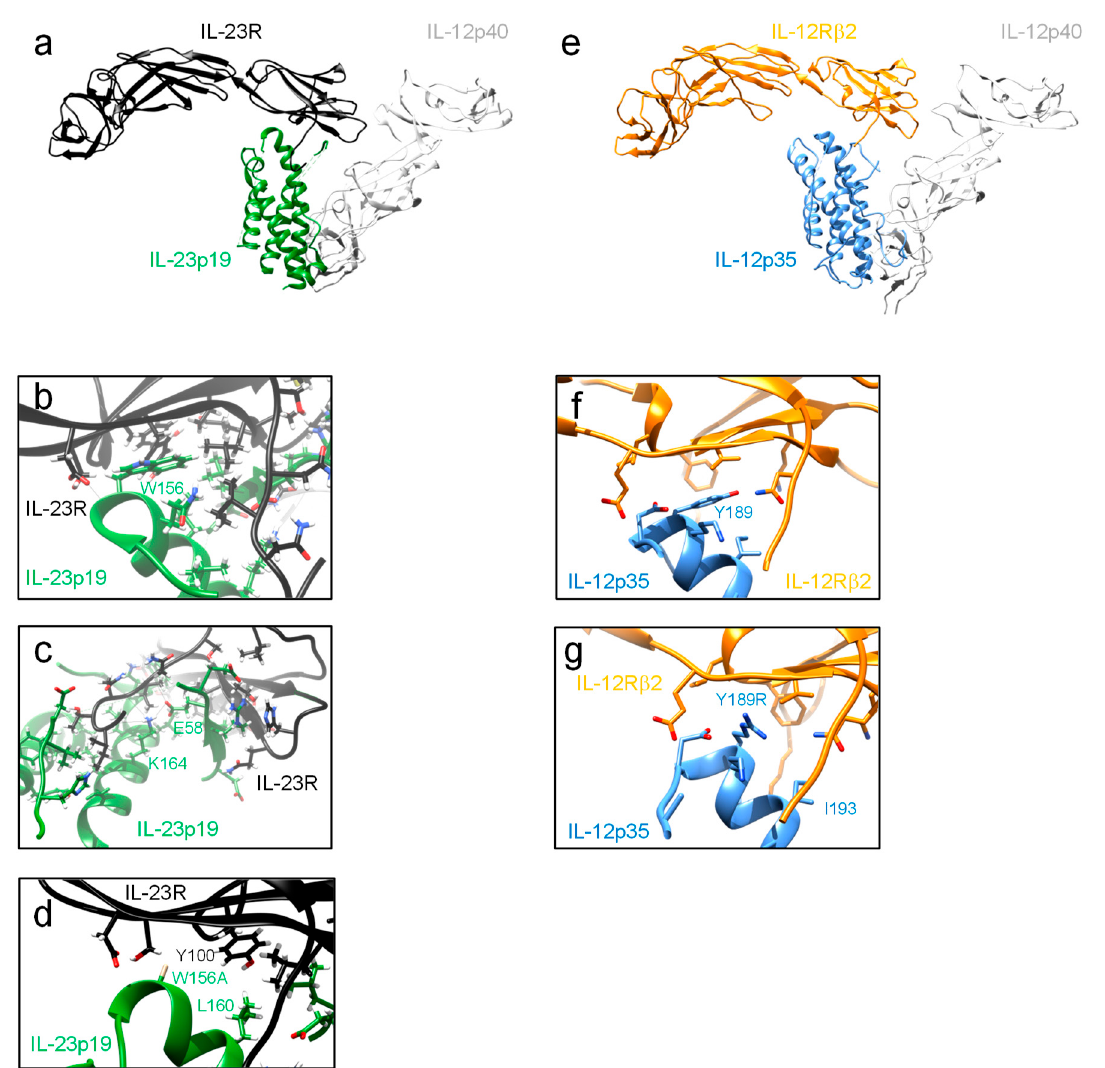
Figure 3. Structures of IL-23:IL-23R and IL-12:IL-12R β 2. ( a ) Ribbon presentation of the hIL-23:hIL-23R structure (PSB 5MZV). ( b ) Close-up view of the hIL-23p19:hIL-23R interface surrounding the central W156. ( c ) Close-up view of the hIL-23p19:hIL-23R interface centering on the N-terminus of the hIL-23R and the IL-23p19 AB loop. ( d ) In silico mutation of W156 into A is displayed. Surrounding residues L160 (hIL-23p19) and Y100 (hIL-23R) are indicated. ( e ) Model of a complex of hIL-12R β 2 and hIL-12 based on the crystal structures of the hIL-23:hIL-23R complex (PDB 5MZV) and the crystal structure of hIL-12 bound to an ustekinumab FAB (PDB 3HMX). ( f ) Model of hIL-12p35 (PDB 3HMX) bound to the hIL-12R β 2. The conserved hIL-12p35 Y189 residue located at the top of helix D is highlighted within the site 3 interface. ( g ) Model of hIL-12p35 Y189R mutation. Residues I193 (hIL-12p35) and F99 and V100 (hIL-12R β 2) corresponding to L160 (hIL-23p19) and Y100 (hIL-23R) are indicated. Molecular graphics images were produced using the UCSF Chimera package from the Resource for Biocomputing, Visualization, and Informatics at the University of California, San Francisco (supported by NIH P41 RR-01081).